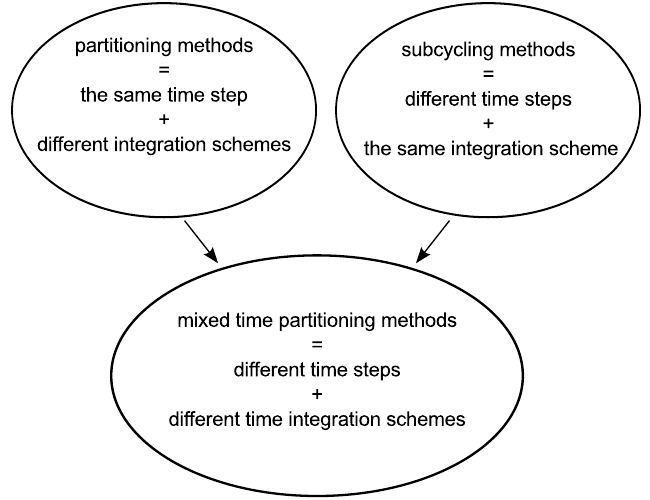
Figure 1. Transition from partial differential equation to approximate solution by using mixed time partitioning methods.